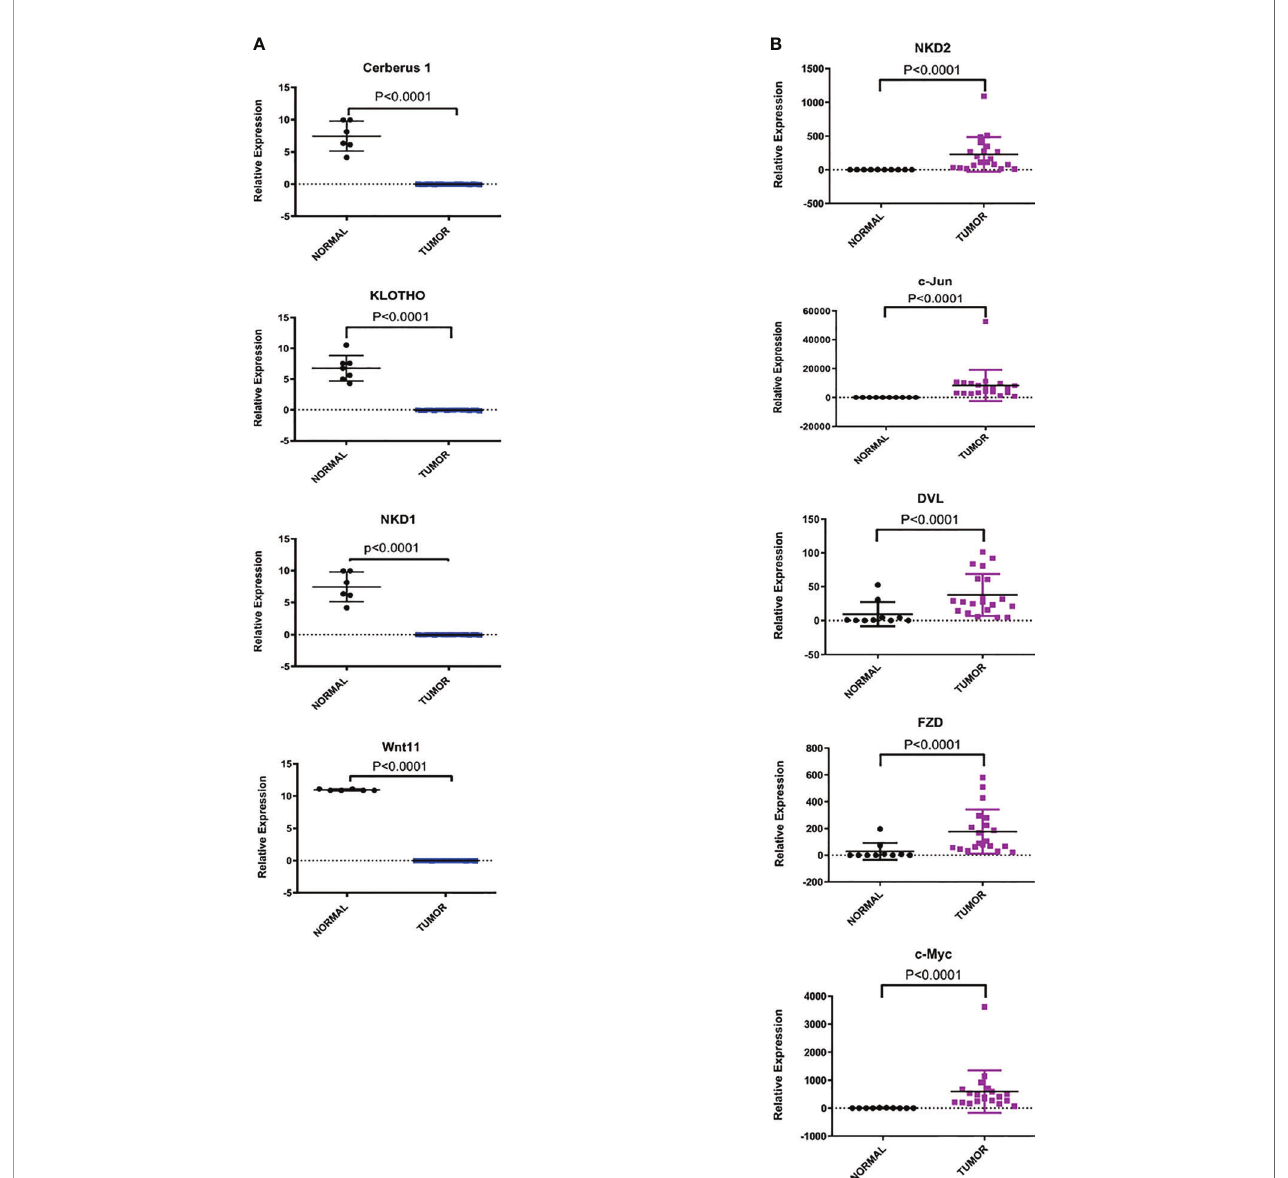
FIGURE 2 | Relative expression of dysregulated genes of Wnt/ b -catenin pathway in CC samples versus normal cervix tissues. The expression level of each gene by RT-qPCR was determined as described in the methods section. Statistical analysis to compare the mRNA expression levels between normal and tumor tissues was performed using an unpaired two-tailed t-test. (A) Representative downregulated genes of the Wnt/ b -catenin pathway. (B) Representative upregulated genes of the Wnt/ b -catenin